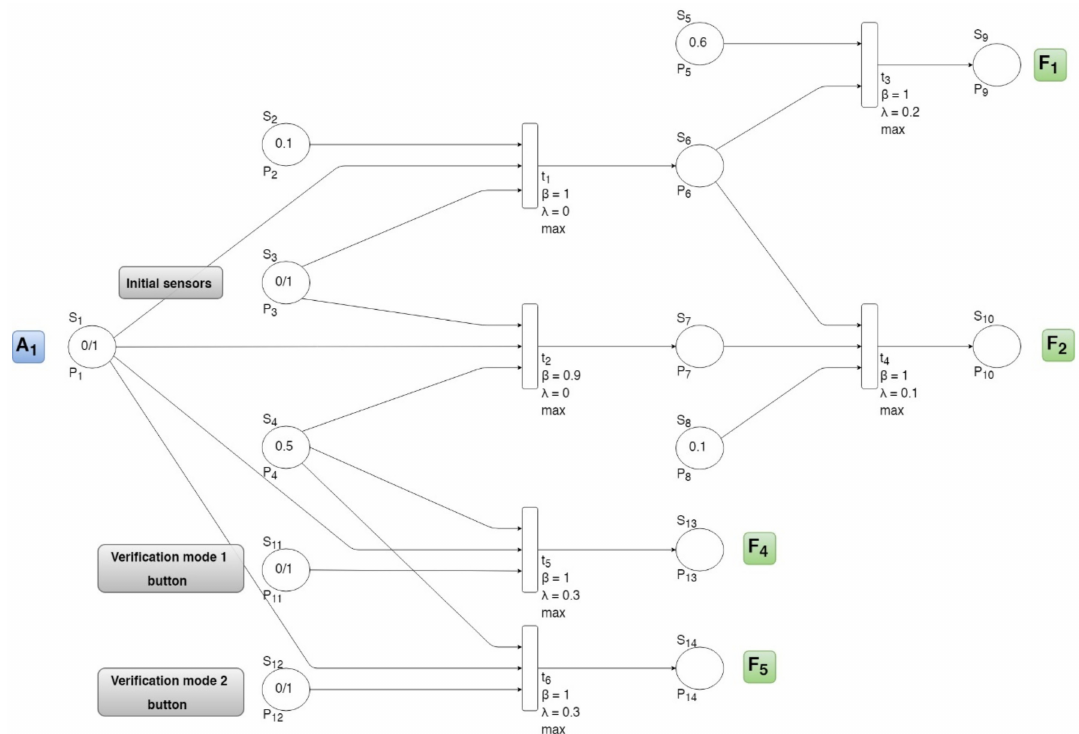
Figure 5. A graphical structure of the fuzzy Petri net algorithm for the transition between the initial stop state (A1) and the different operation modes of the